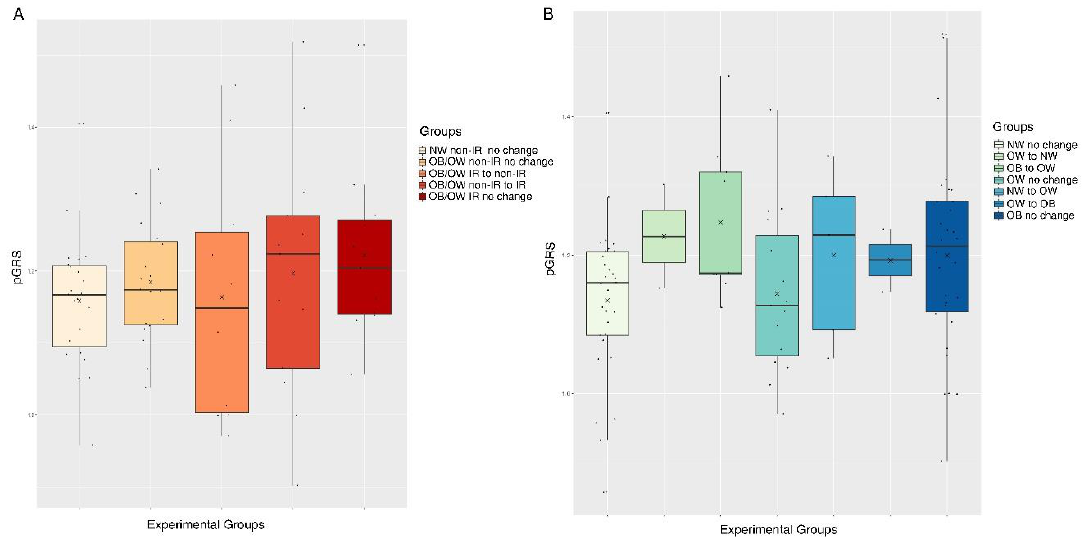
Figure 3. Boxplots for the continuous pGRS according to the two available experimental group classifications of study population 2. ( A ) pGRS boxplots according to joint longitudinal trajectories for obesity and insulin resistance (IR). ( B ) pGRS boxplots according to the longitudinal trajectories for obesity. The x symbol in plots represents the mean pGRS for each group. Abbreviations: NW, normal weight; OB, obese; OW, overweight; IR, insulin resistance.